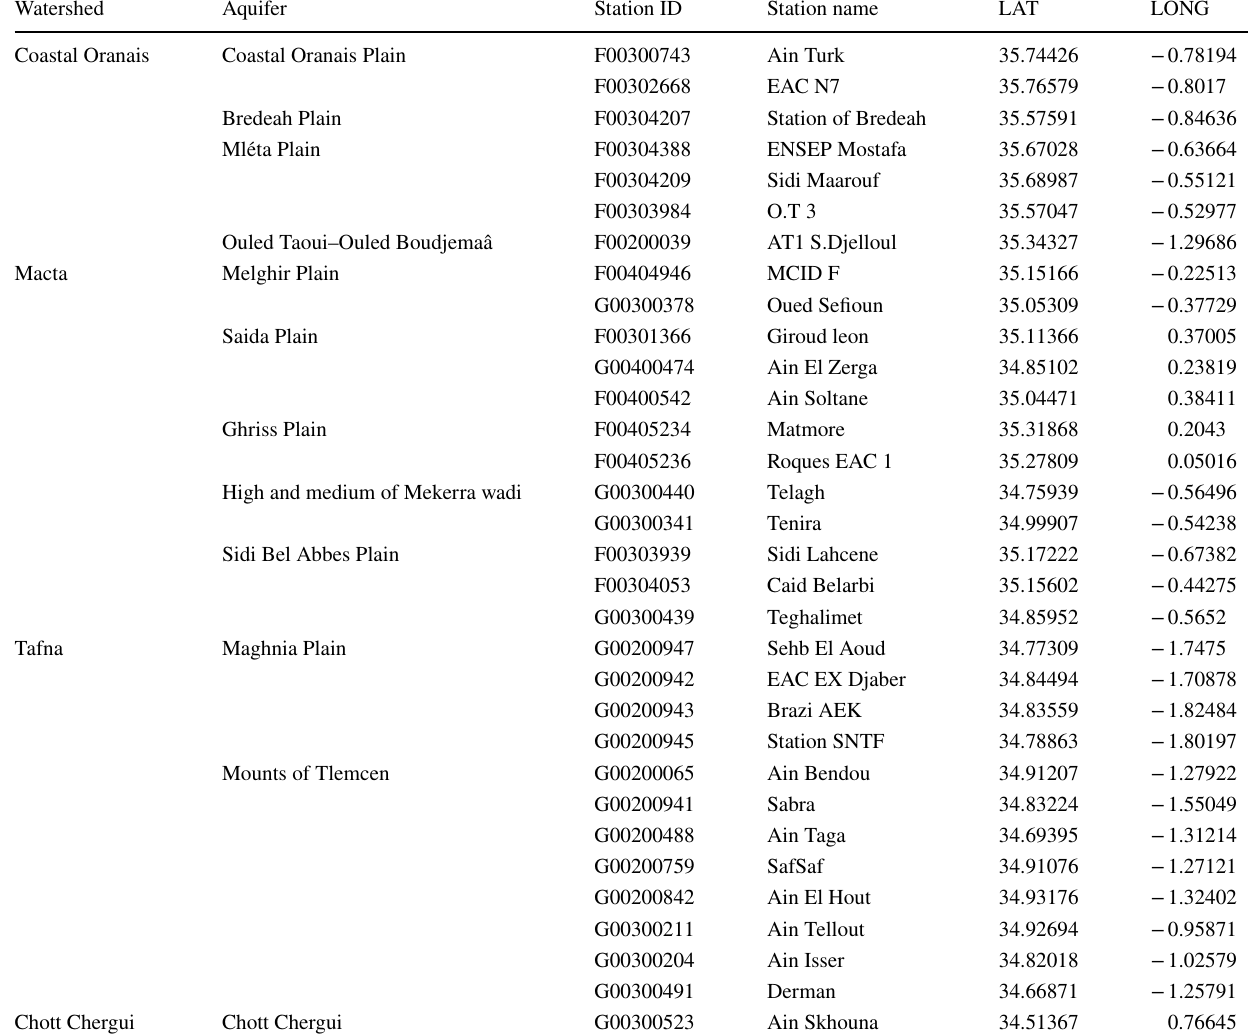
Table 1 Sampling location with their latitude and longitude